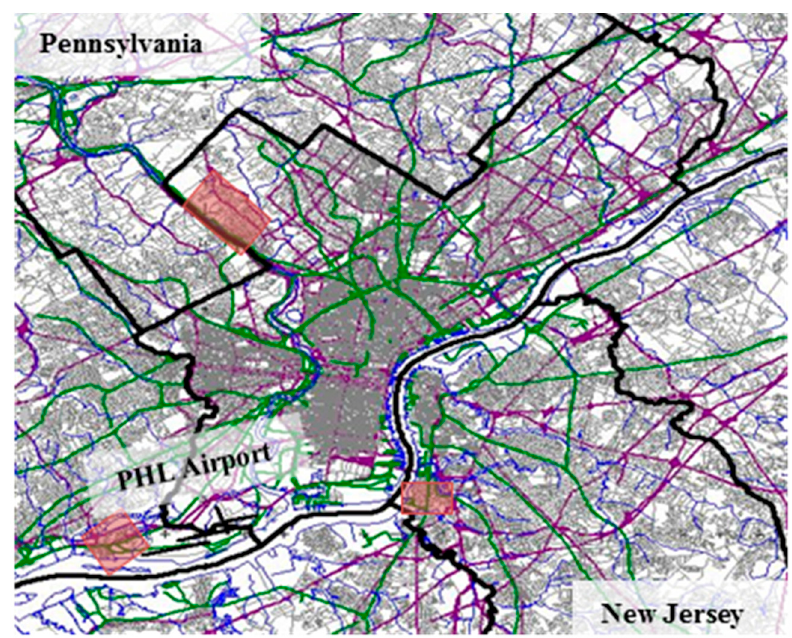
Figure 3. Measurement regions for the pilot sleep study conducted near Philadelphia International Airport. Measurement areas are highlighted in red.